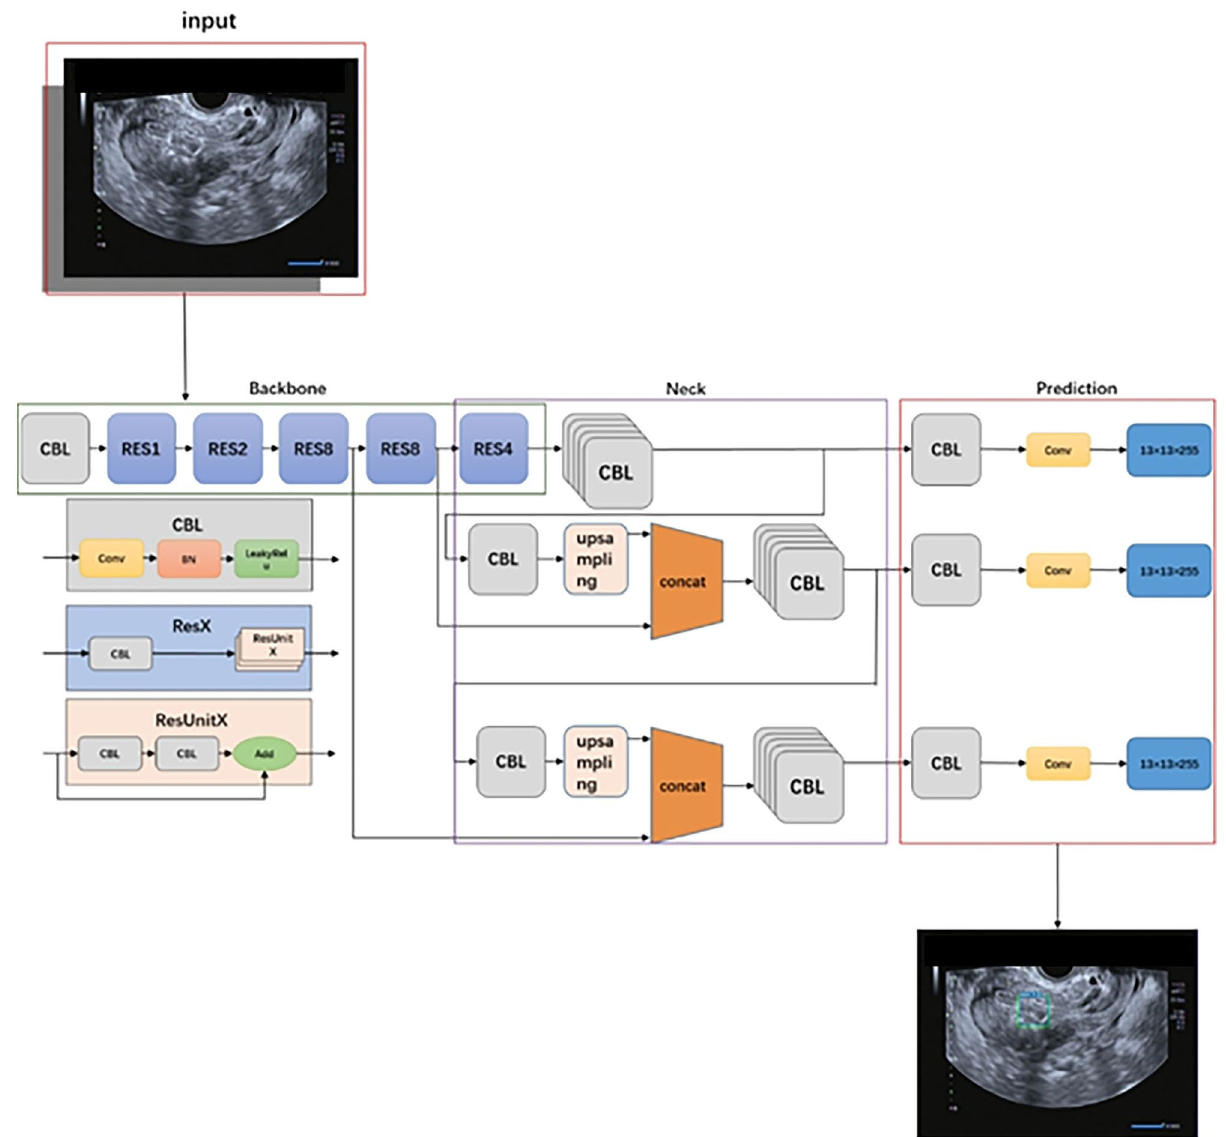
Figure 3. Outline of the DCNN for uterine fibroid detection. Schematic representation of the DCNN network architecture for uterine fibroid detection from ultrasound images. The CBL in front of each Res module acts as a downsampling. Con-cat = tensor concatenation, which expands the dimensionality of two tensors. Add: tensor summing, no dimensionality expansion. Convs Convolutional layers, CBL Minimum component in the structure of the YOLOv3 network united by the Conv + Bn + leaky-ReLU activation function. Res-Unit Residual structure, Res-X Large component in Yolov3 consisting of a CBL and X